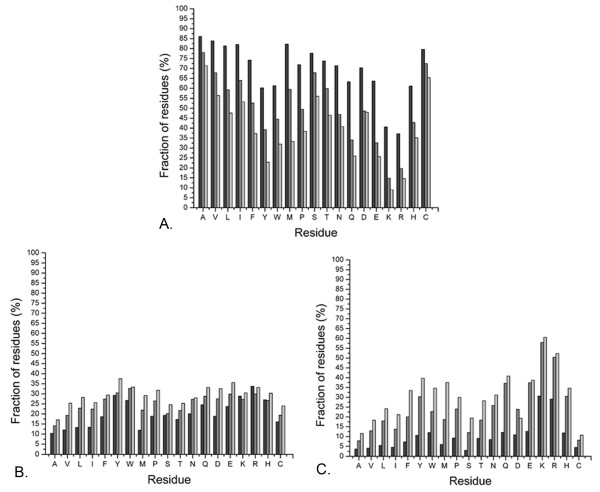
Nodes of a clique exhibit greater propensity to get completely buried. Percentage fraction of individual residues categorized into clique-nodes (dark gray), non-clique nodes of clique containing networks (gray) and nodes of networks devoid of cliques (light gray) sorted according to their exposure to solvent in terms of burial ratio: (A). for burial ratio < = 0.05 (completely buried), (B). for 0.05 < burial ratio < = 0.15 (partially buried with lower exposure to the solvent), (C). for 0.15 < burial ratio < = 0.3 (partially buried with higher exposure to the solvent).